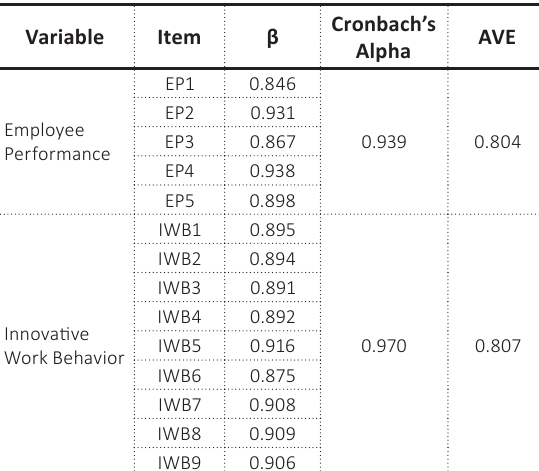
Table 2. Convergent validity and internal consistency